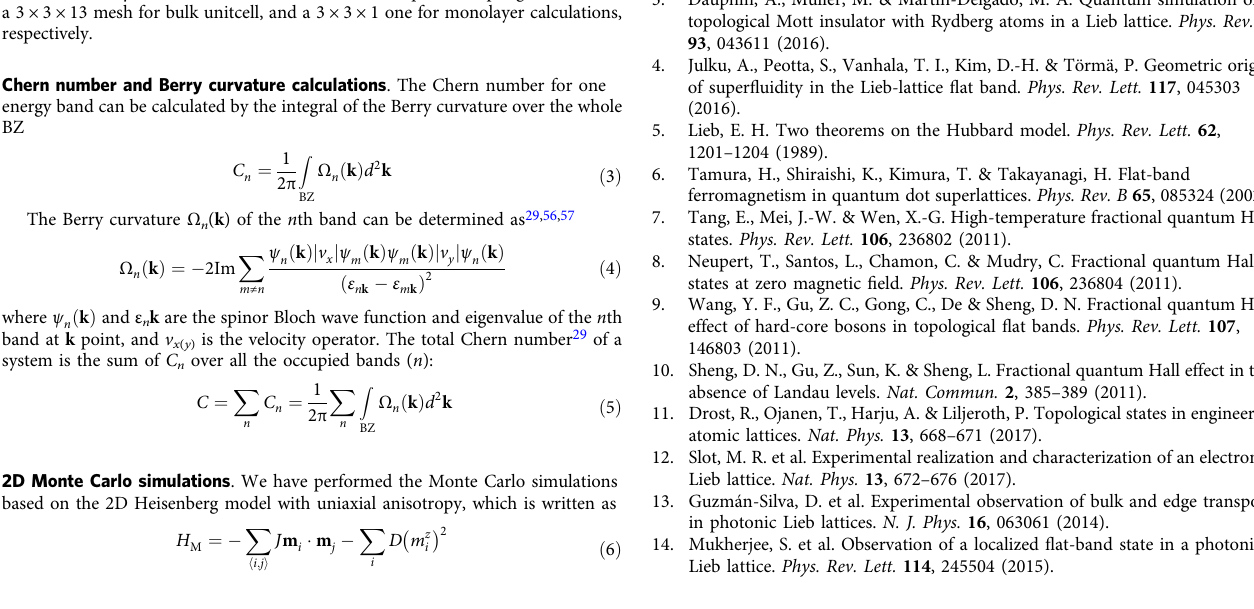
Fig. 5 Magnetic phase transitions as a function of hole doping concentrations. a DFT-calculated Δ E Δ E ¼ E sp 2 C-COF. b n h -dependent magnetic phase diagram for monolayer